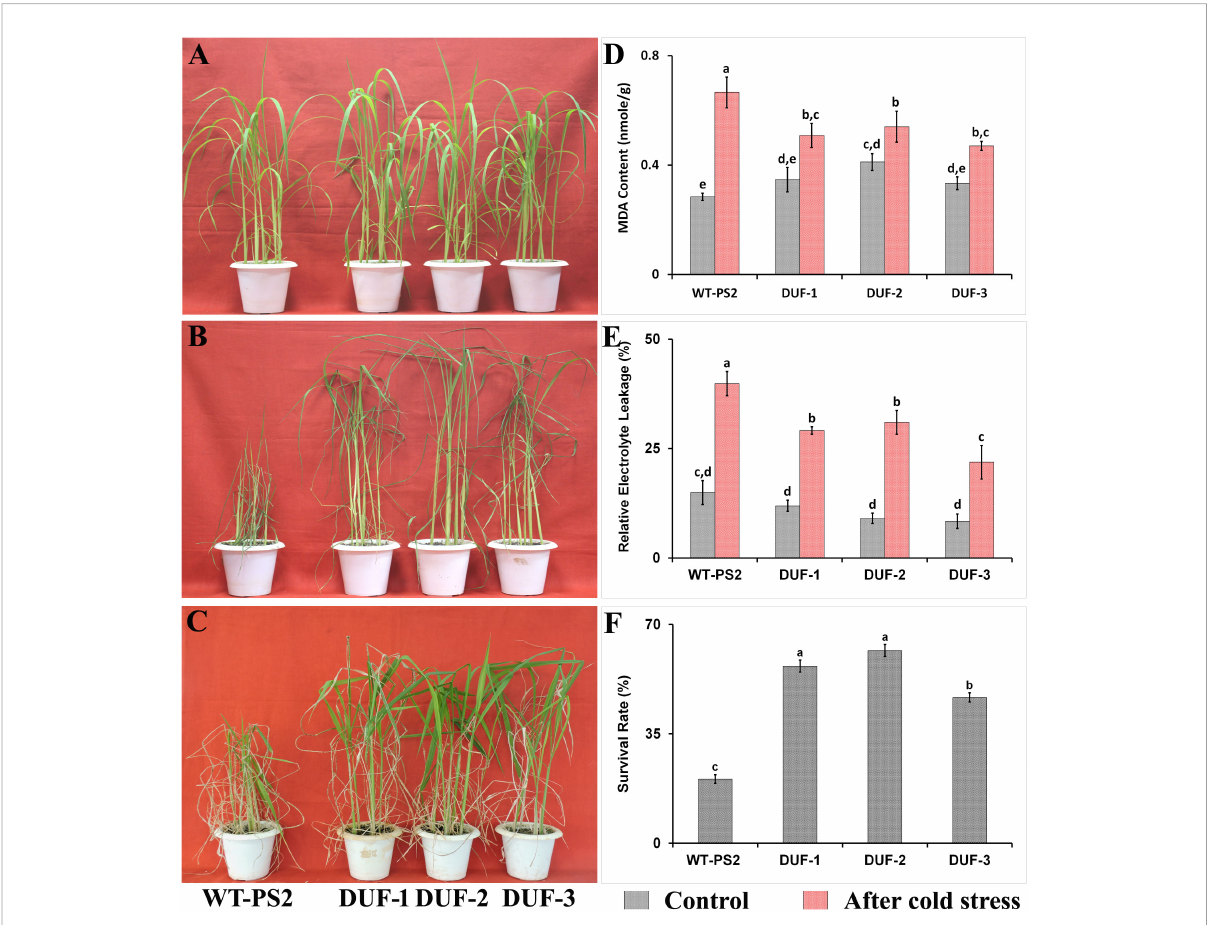
FIGURE 6 Cold stress tolerance assays of AtRd29A::OsSRDP transgenic lines with WT plants. (A) Phenotype of the fourth to fi fth leaf stages of WT and OsSRDP transgenic rice seedlings, before cold treatment. (B) The fourth to fi fth leaf stages of WT and AtRd29A::OsSRDP transgenic seedlings were under cold stress at 12°C for 12 days, and (C) recovery for 10 days under normal growth conditions. MDA content (D) , relative electrolyte leakage (E) , the survival rates of wild-type and AtRd29A::OsSRDP transgenic rice plants after 10 days of recovery (F) . Each value is the average of three independent biological replicates and the vertical bar indicates ± SD. Standard error of means (SD/ √ N; N = 3) are used as error bars, and alphabets above the vertical bars represent statistically signi fi cant differences (Duncan ’ s Multiple Range Test: p ≤ 0.05) between wild-type and AtRd29A::OsSRDP transgenic